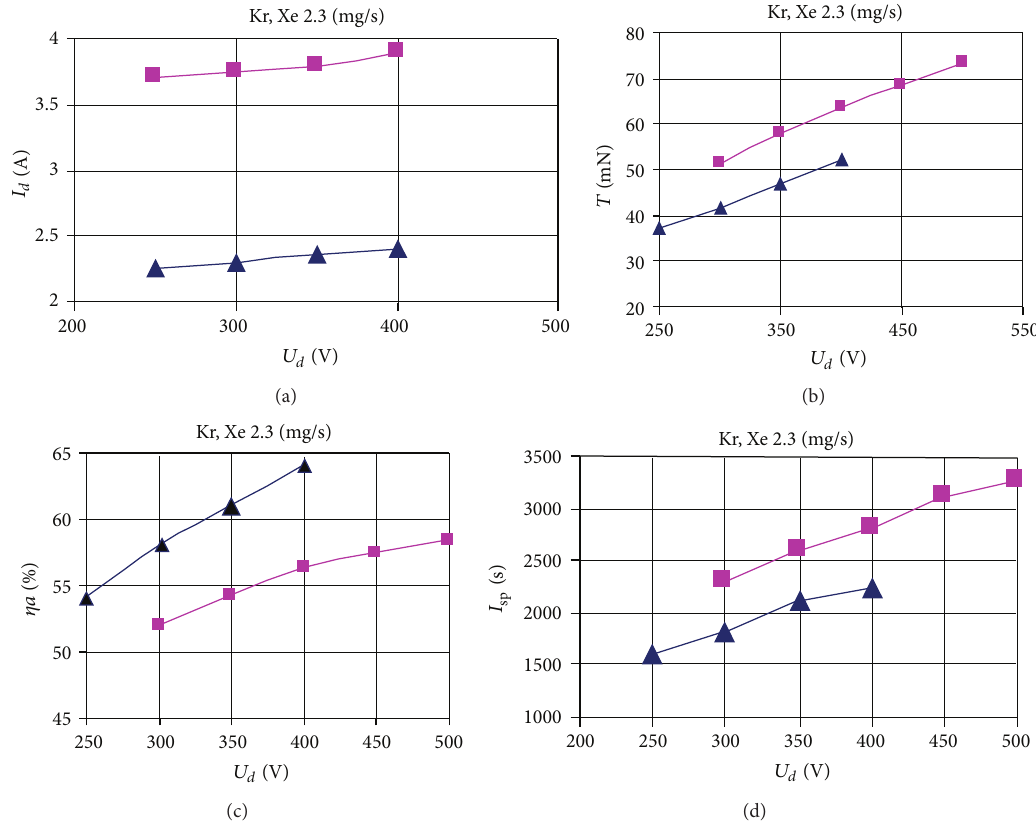
Figure 8: ATON A-3 (a) current-voltage characteristics of the discharge and the dependences of (b) the thrust, (c) anode efficiency, and (d) specific impulse on the discharge voltage at the anode mass flow rate of 2.3 mg/s in operation on Kr, optimized model (purble square ◼ ), and Xe (blue triangle 󳵳